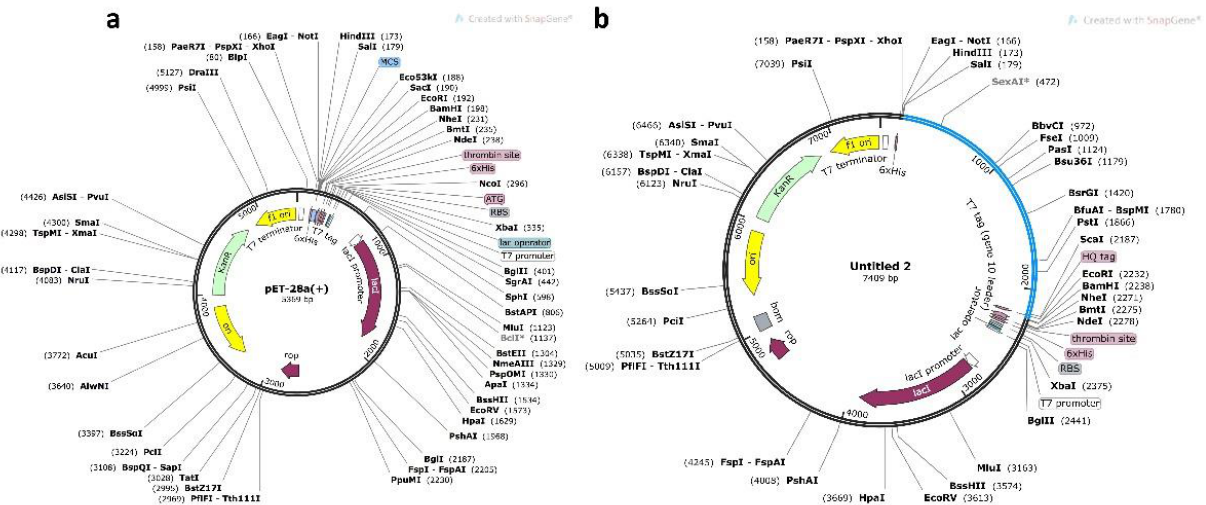
Figure 6. In silico restriction cloning of the final vaccine construct into the pET28a (+) expression vector where the blue part represents the vaccine insert and black circle shows the vector. ( a ) represents the negative control construct while ( b ) represents the vaccine construct inserted into the vector shown as blue.